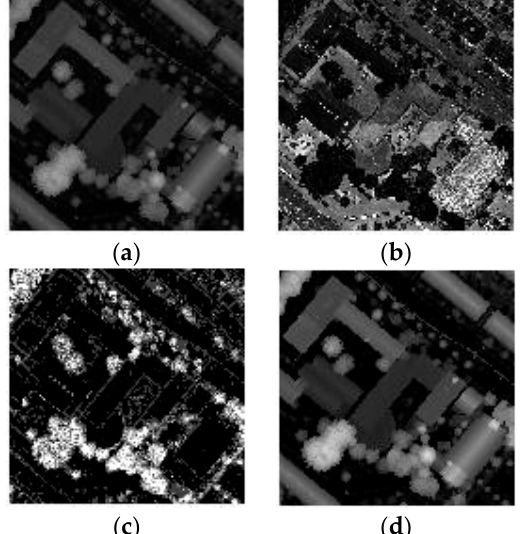
Figure 3. Images from the highest point within each pixel: ( a ) elevation; ( b ) intensity; ( c ) the number of returns; ( d ) height difference between the highest point in a pixel and the lowest point in a 20 × 20 m neighborhood.